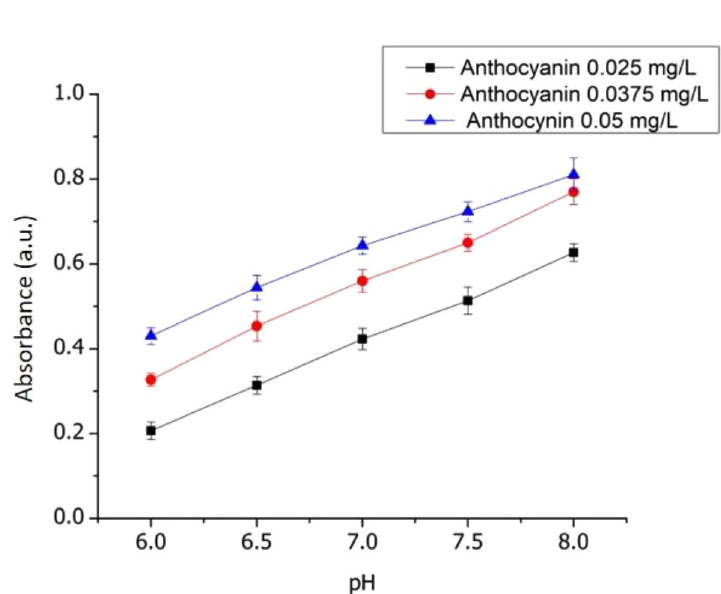
Figure 8. Effect of ACN concentration on sensitivity optical pH